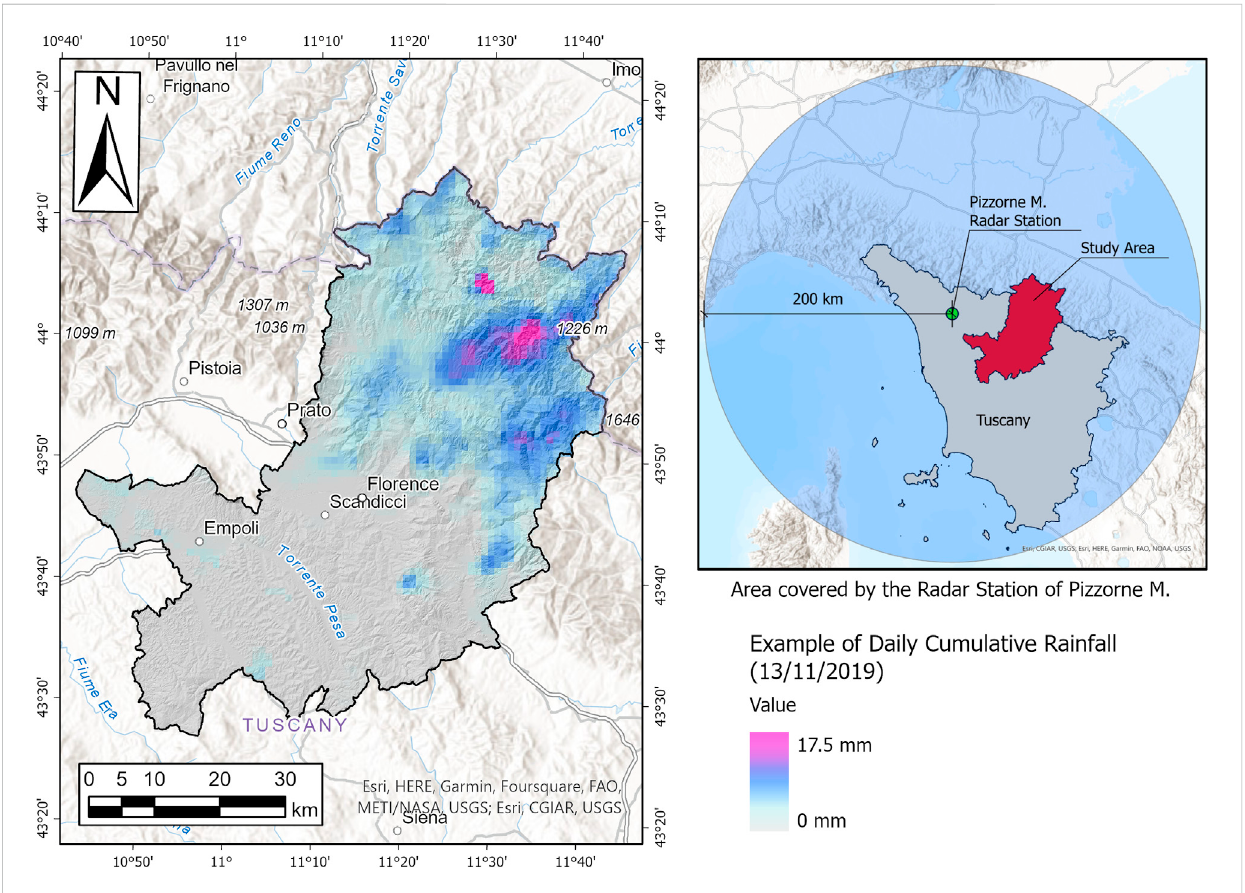
FIGURE 2 Example of radar daily cumulative rainfall (for 13/11/2019) from meteorological radar